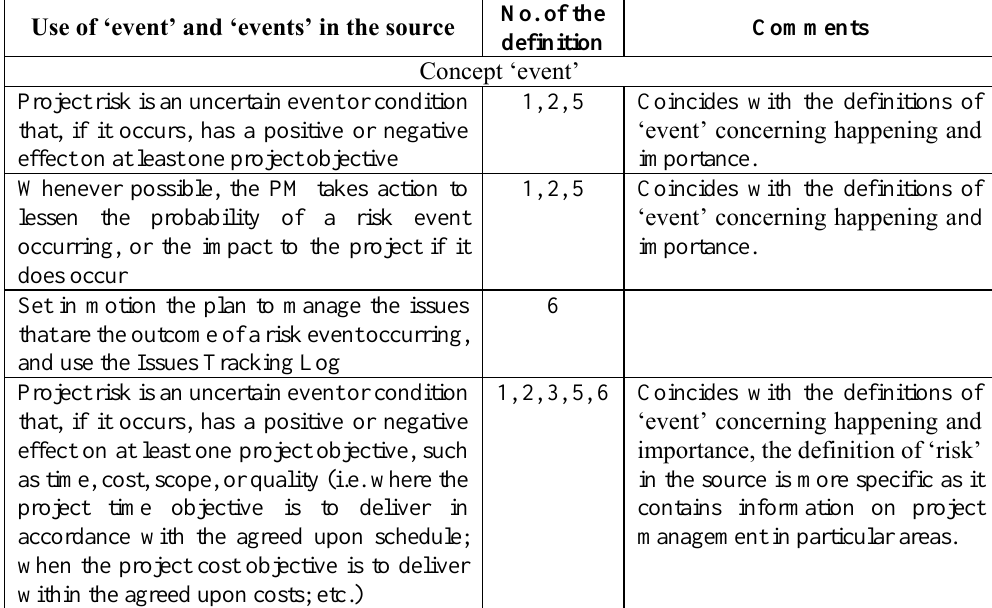
Table 7. Accordance with the